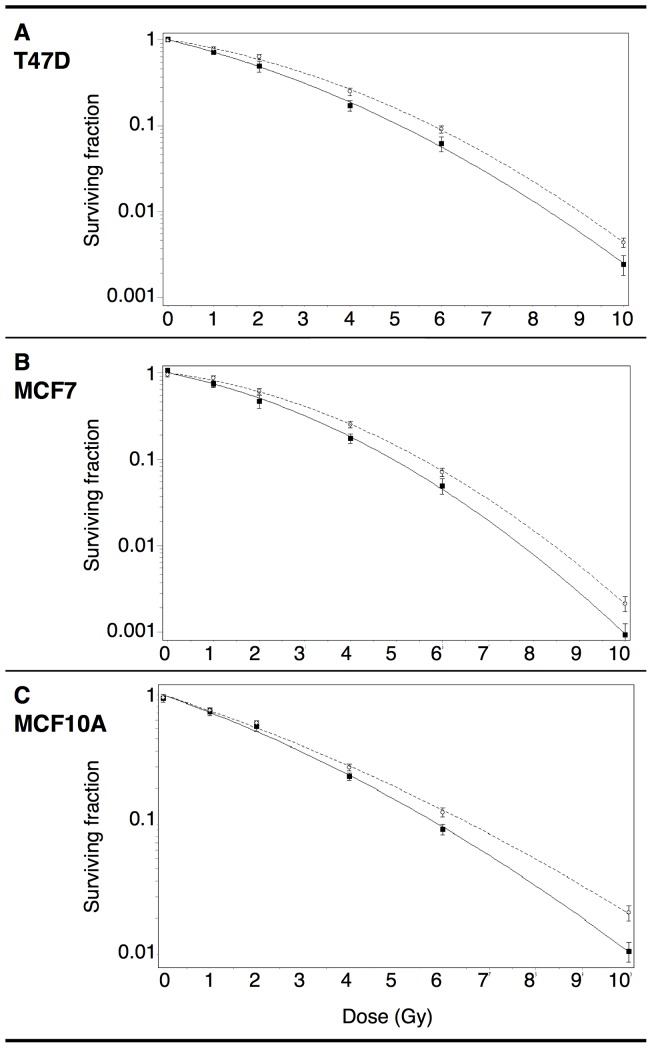
Dose-response curves for clonogenic survival of ALDH− cells and ALDH+ CSCs.Sorted ALDH− (squares, continuous lines) and ALDH+ (circles, dotted lines) T47D (A), MCF7 (B) and MCF10A (C) cells were exposed to various doses of ionizing radiation. Lines represented fitted curves according to linear quadratic regression. Results are representative of at least three independent experiments. Error bars represent standard deviation. Statistical significance of the difference between dose-response curves (p<0.05) was performed using one-way Analysis of Variance (one-way ANOVA) with Bonferroni correction for pairwise group comparisons.